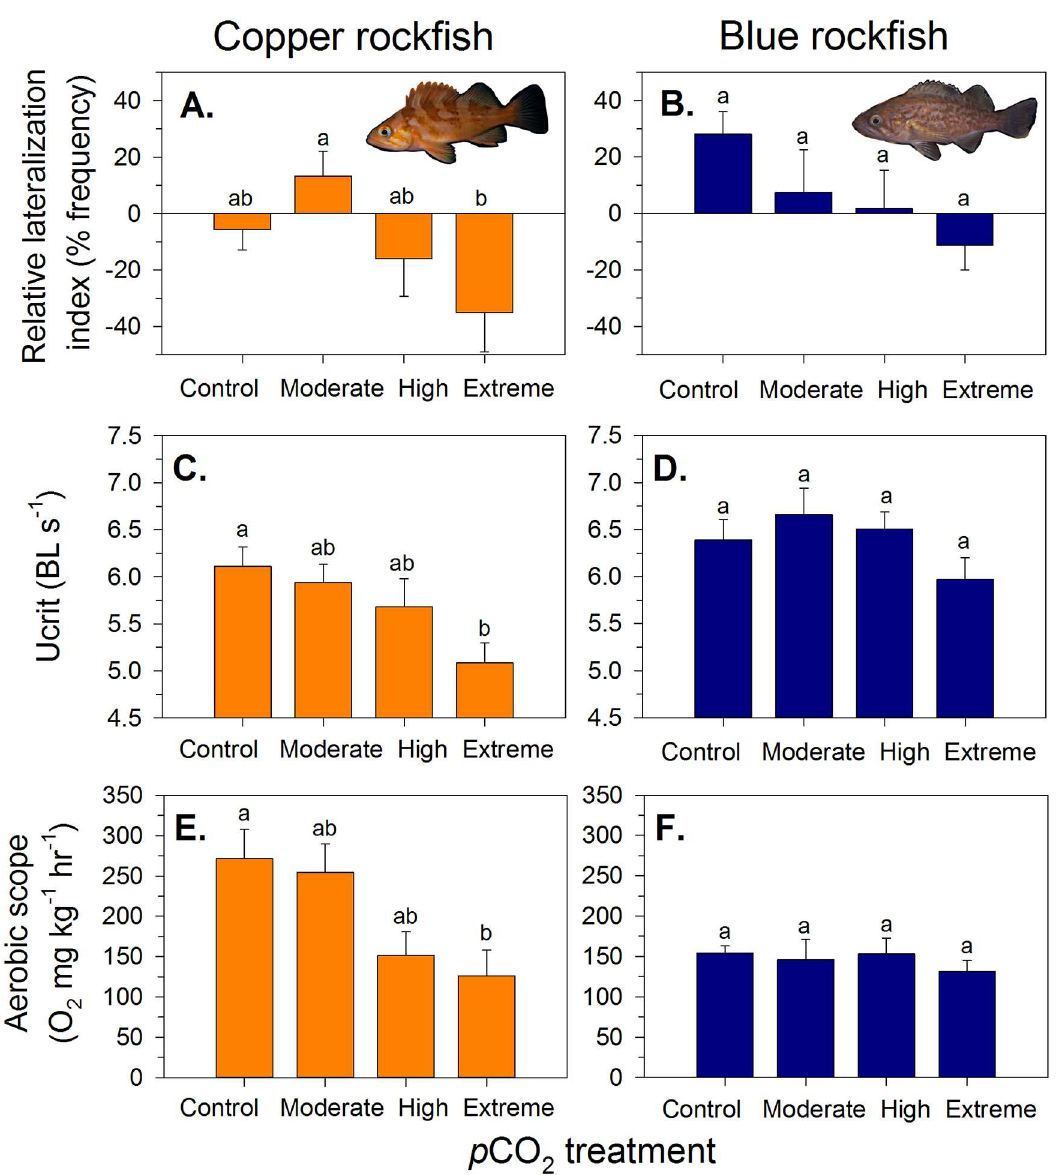
Fig 1. Changes in behavioral lateralization, critical swimming speed, and aerobic scope of juvenile copper and blue rockfish as a function of p CO 2 treatment exposure history. (A, B) Behavioral lateralizationis measuredusing the relativelateralizationindex (negative values = right turn bias in a detour test). (C,D) Critical swimmingspeed (U crit ) is the maximum sustainedspeedin body lengthsper second. (E,F) Aerobicscope represents the difference betweenmaximum and resting metabolicrates (measured as oxygen consumption) and is a proxy for the capacity for aerobic activity. Bars are mean values ( ± SE). Letters over bars represent results of Tukey HSD post-hoc tests; significantly different means do not share letters in common. Note: Due to logisticalconstraints all behavioral and physiological trials occurred in control seawater ( p CO 2 ~550 μ atms).